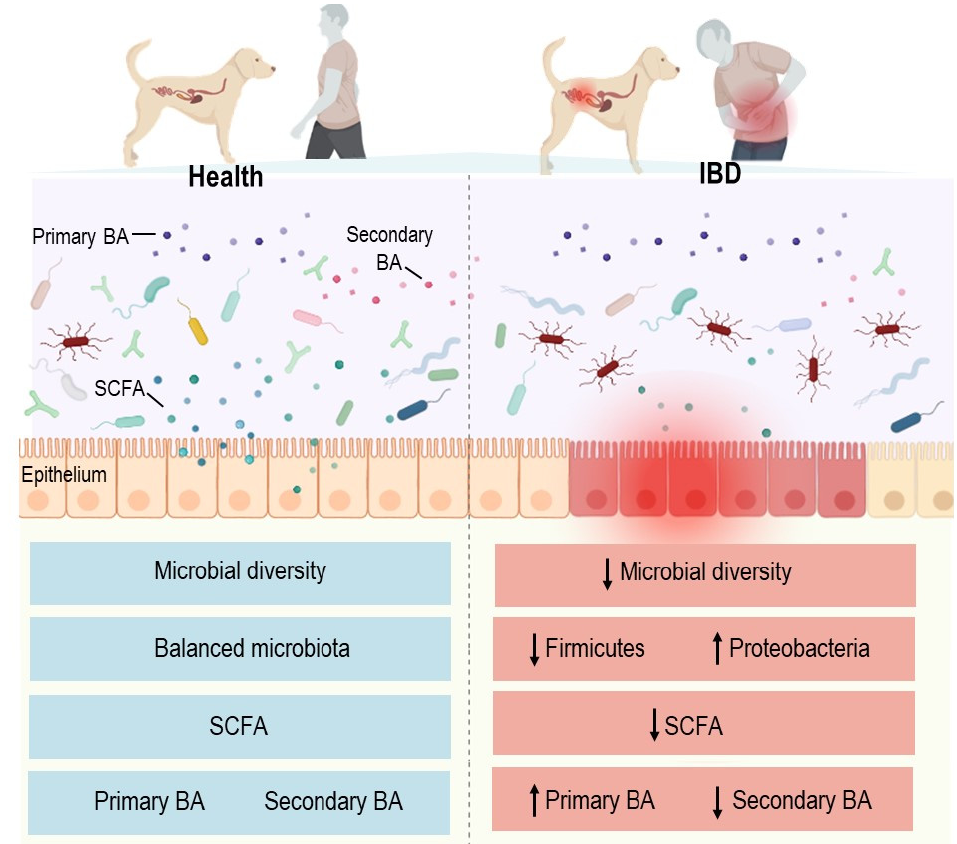
Figure 3. Humans and pet dogs show similar gut microbiota disturbances during IBD, characterized by a reduction in microbial diversity, a reduction in Firmicutes and an increase in Proteobacteria; a reduction in short-chain fatty acids (SCFAs); an increase in primary bile acids (BAs); and a reduction in secondary BAs.